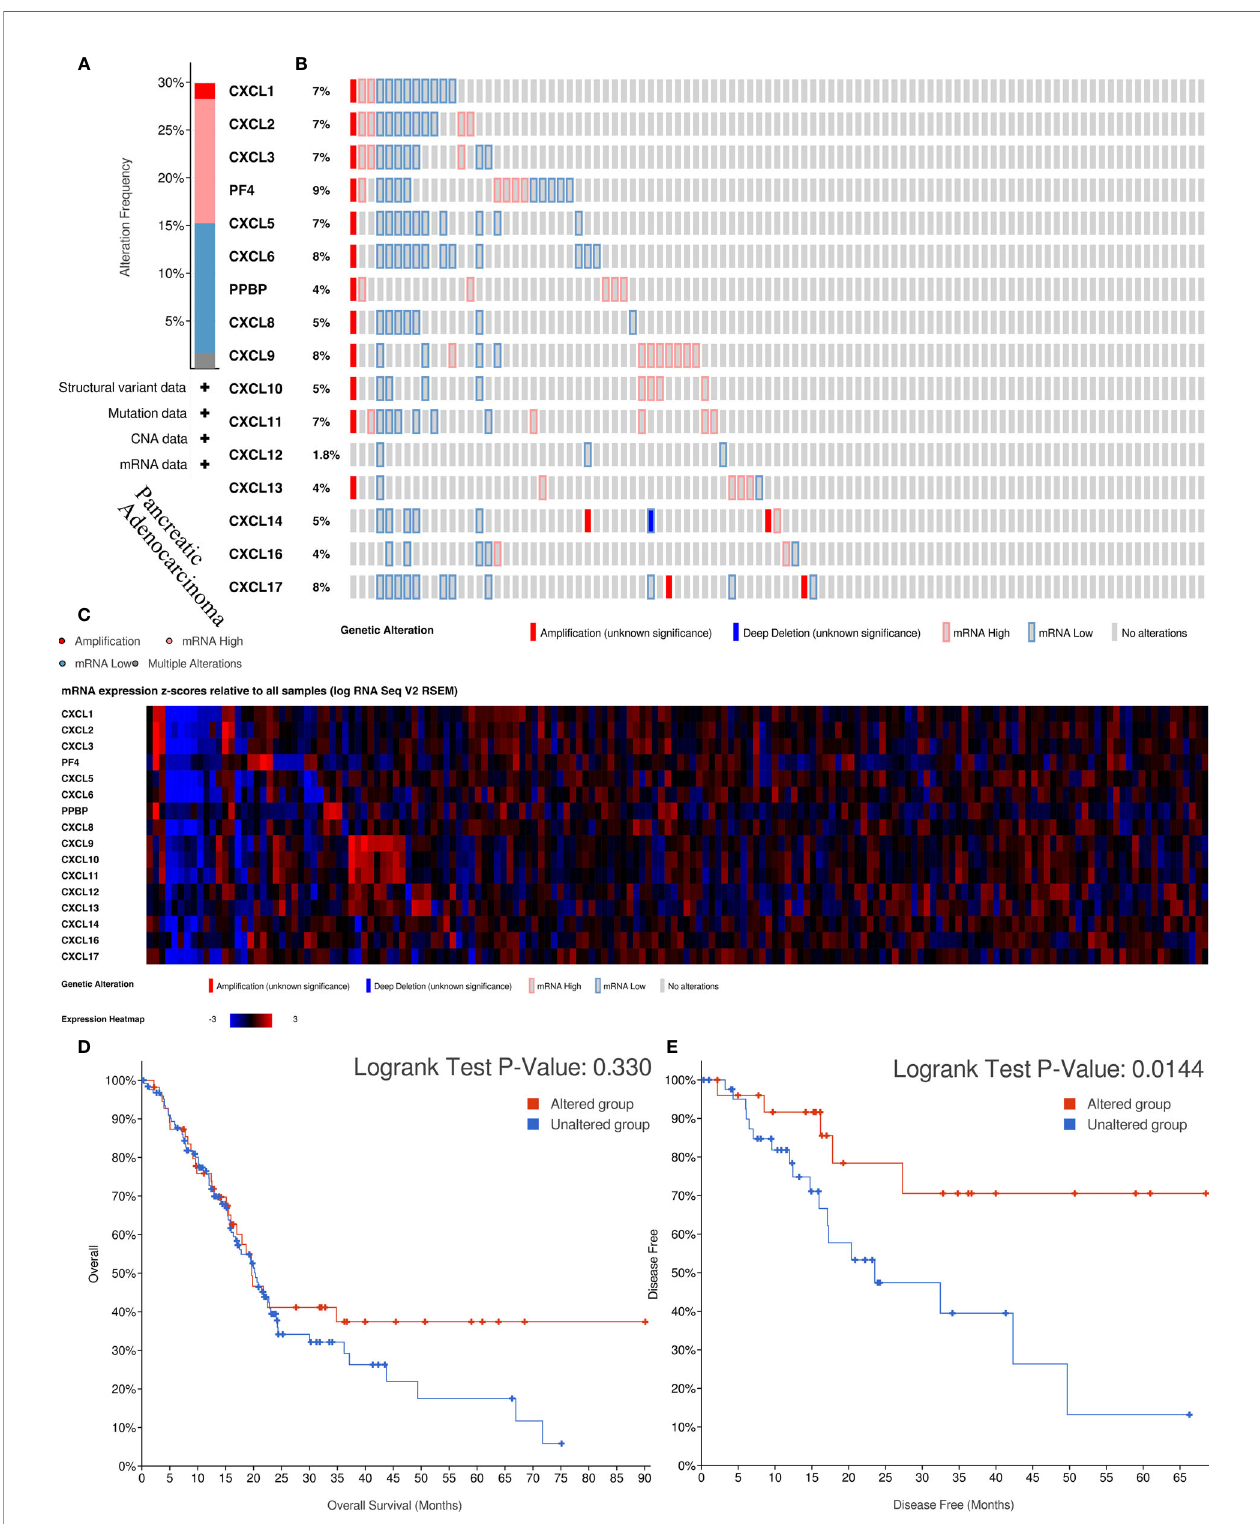
FIGURE 4 | The biological functions and survival analysis of mutated CXC chemokines (cBioportal). (A) Summary of alterations in different expressed CXC chemokines family in PAAD. (B) Genetic alterations in CXC chemokines in PAAD. (C) The miRNA expression heatmap of CXC chemokines. (D, E) Survival curves of PAAD patients in altered and unaltered groups of the CXC chemokines. (D) OS; (E)